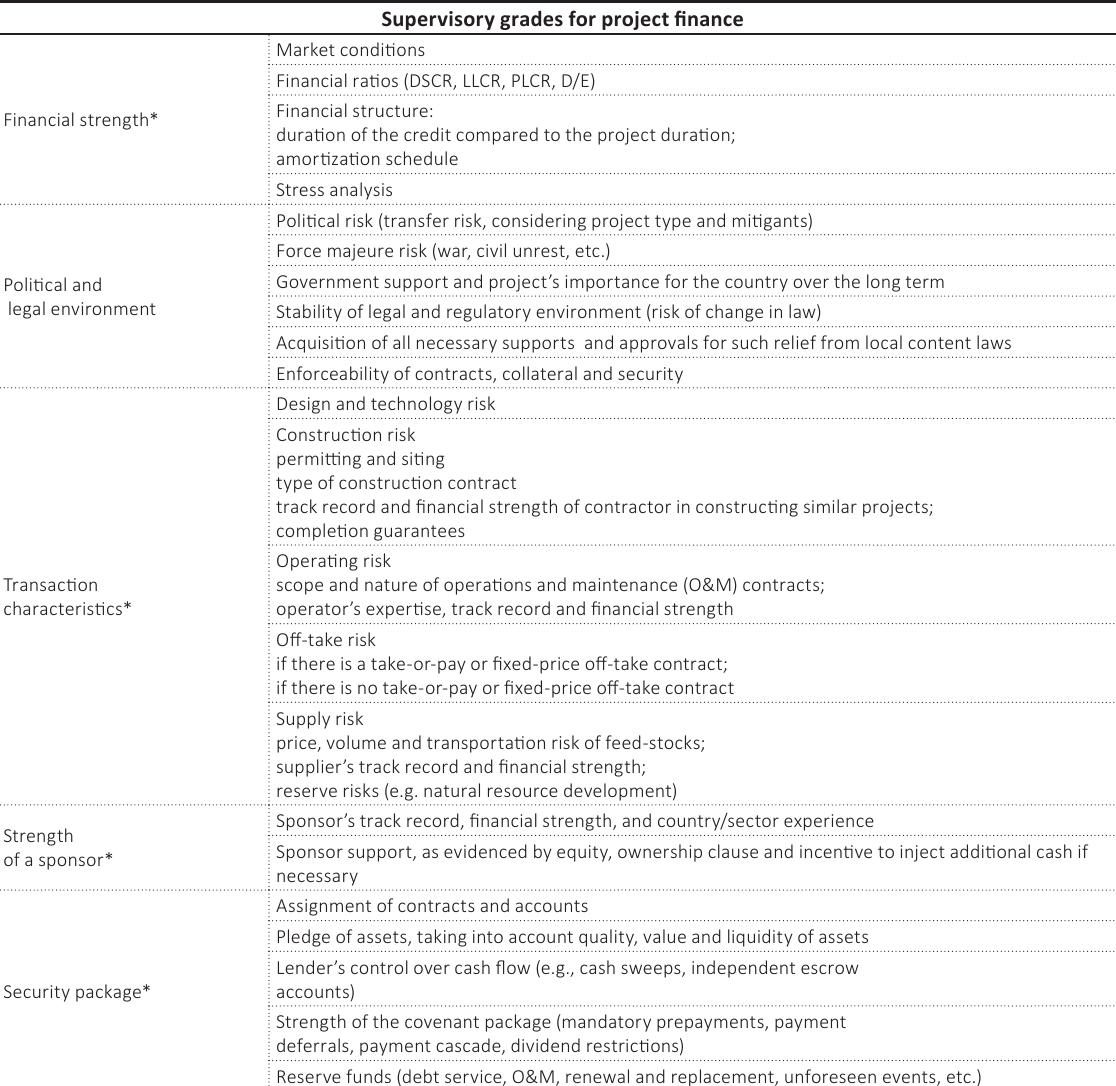
Source: Compiled based on BCBS